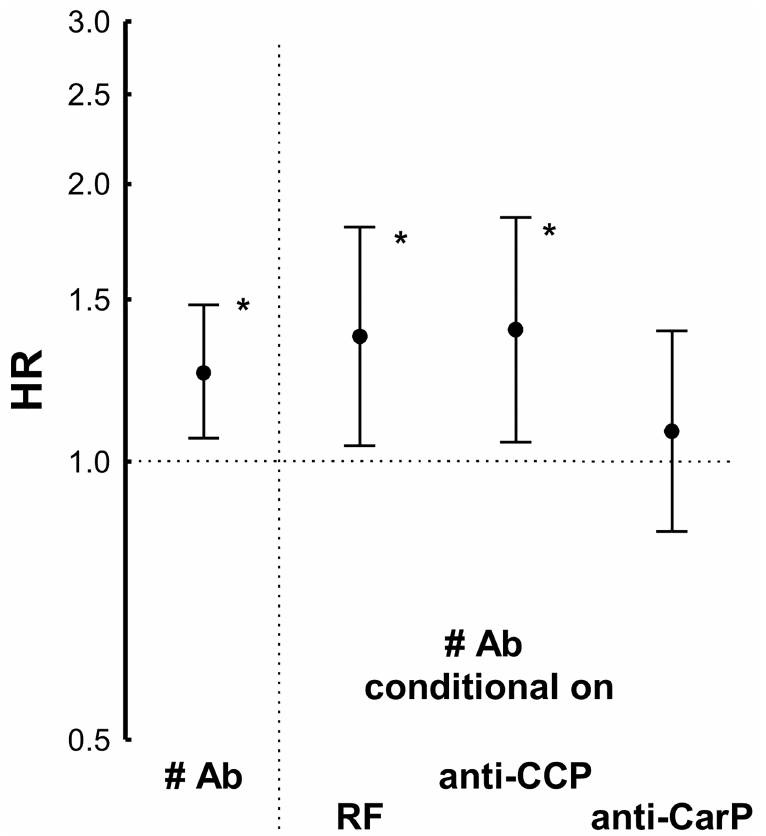
Fig 5. Conditional analysis of the HR observed with the number of autoantibodies. The HR for the numberof antibodies(# Ab) obtainedin Cox proportional analysiswas considered either on itself (to the left of the dotted vertical line) or conditional on the presenceof each of the three specific autoantibodies (to the right of the dotted vertical line). The asterisks, * , denote significantly increasedHR.